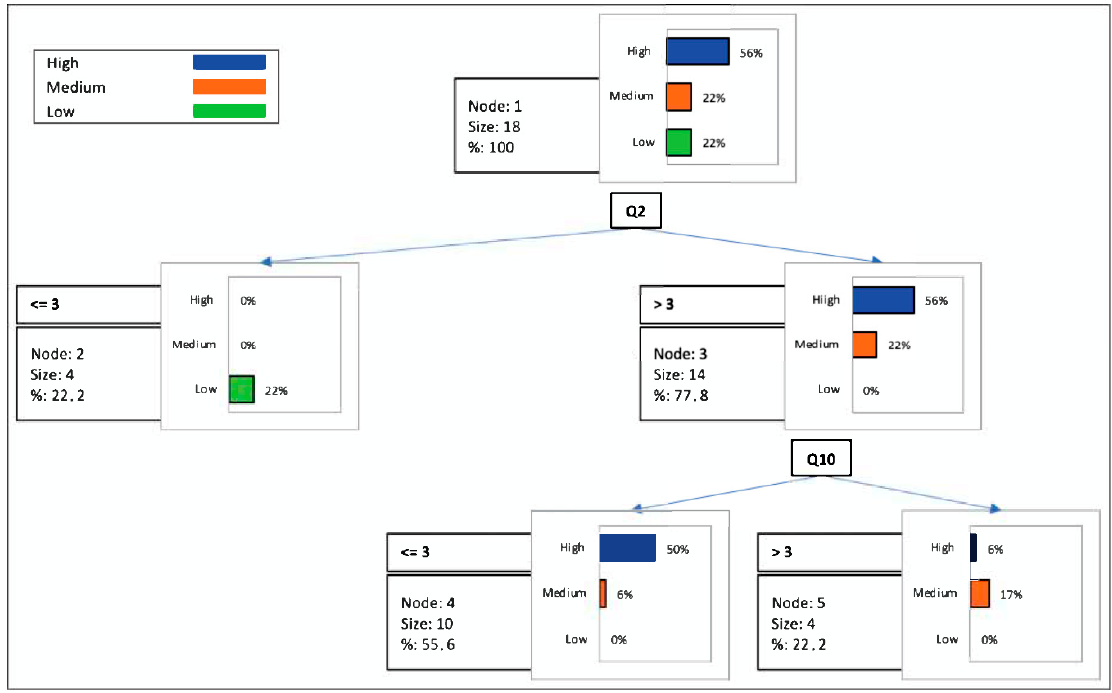
Figure 8. Classification tree of the samples.